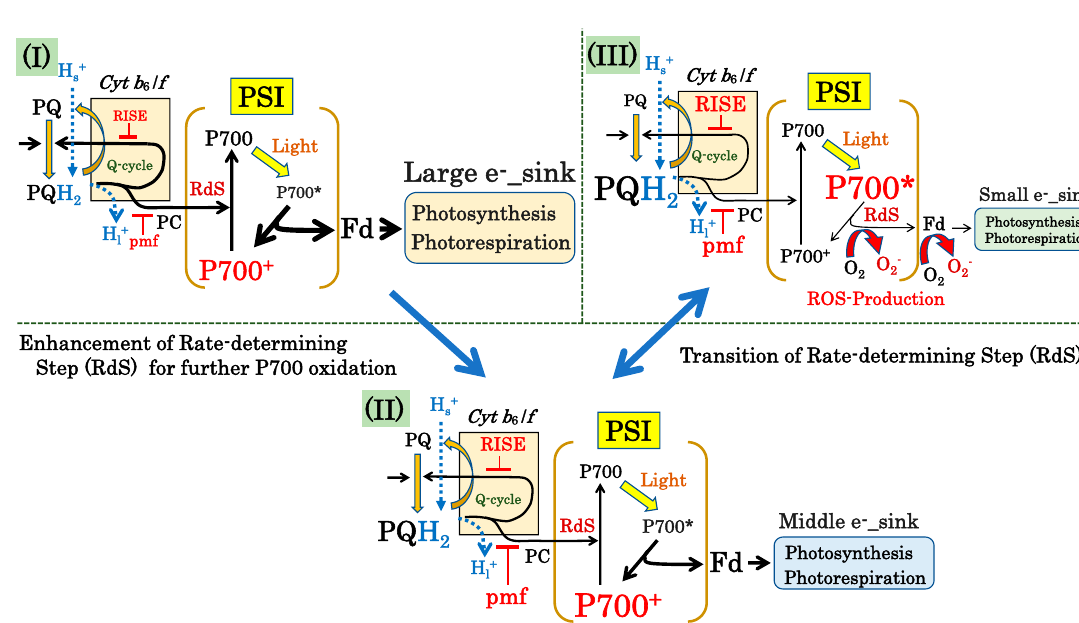
Figure6. TheP700oxidationsystemandROSproductionmechanism.